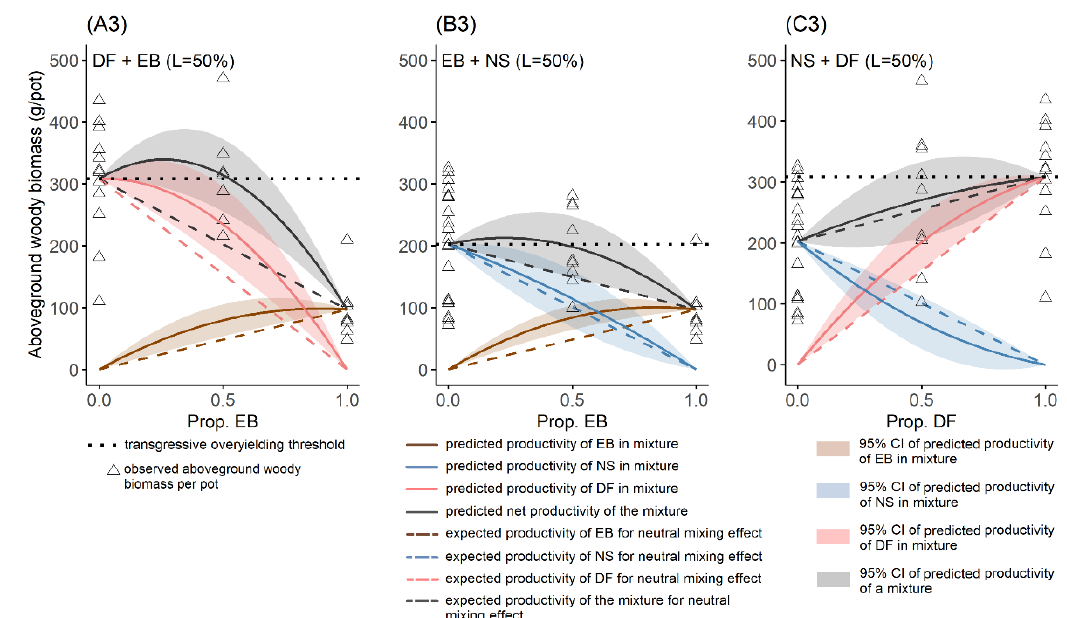
Figure 6. Cross diagrams showing the mixing effect of European beech (EB), Norway spruce (NS), and Douglas fir (DF) seedlings growing in monospecific and mixed pots under 10%, 20%, and 50% light availability levels. The points present the observed aboveground woody biomass per pot (g). The overyielding or underyielding effect is significant when the prediction curve’s confidence bands do not overlap with the reference line. Mixed Douglas fir and European beech pots under 10% light availability level: DF+EB (L=10%) ( A1 ), mixed Douglas fir and European beech pots under 20% light availability level: DF+EB (L=20%) ( A2 ), mixed Douglas fir and European beech pots under 50% light availability level: DF+EB (L=50%) ( A3 ), mixed European beech and Norway spruce pots under 10% light availability level: EB+NS (L=10%) ( B1 ), mixed European beech and Norway spruce pots under 20% light availability level: EB+NS (L=20%) ( B2 ), mixed European beech and Norway spruce pots under 50% light availability level: EB+NS (L=50%) ( B3 ), mixed Norway spruce and Douglas fir pots under 10% light availability level: NS+DF (L=10%) ( C1 ), mixed Norway spruce and Douglas fir pots under 20% light availability level: NS+DF (L=20%) ( C2 ), mixed Norway spruce and Douglas fir pots under 50% light availability level: NS+DF (L=50%) ( C3